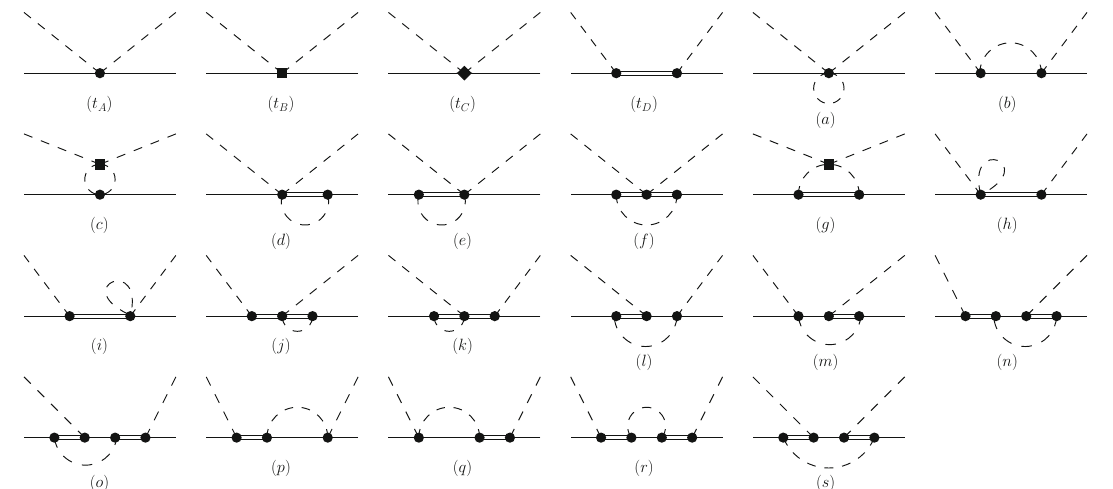
mesons, respectively. The dot, square and diamond represent vertices coming from Lagrangians of O ( p 1 ) , O ( p 2 ) and O ( p 3 ) , in